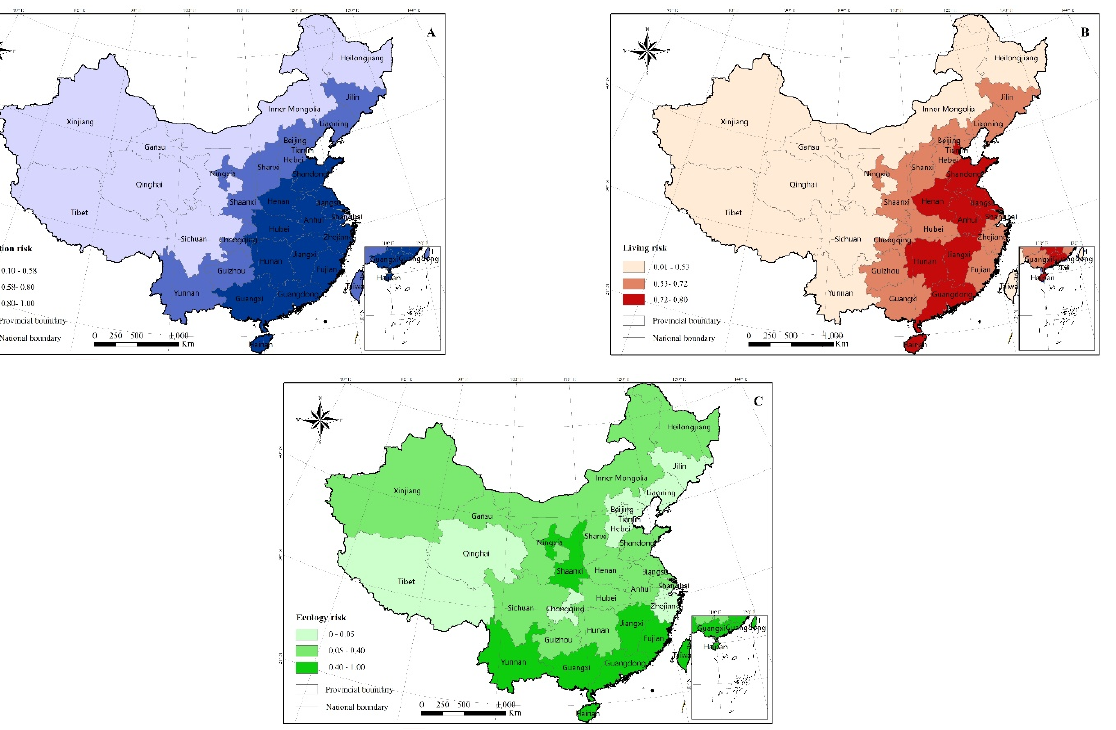
Figure 3. Distribution pattern of production ( A ), living ( B ), and ecology ( C ) risk level at provincial scale under climate change scenario.